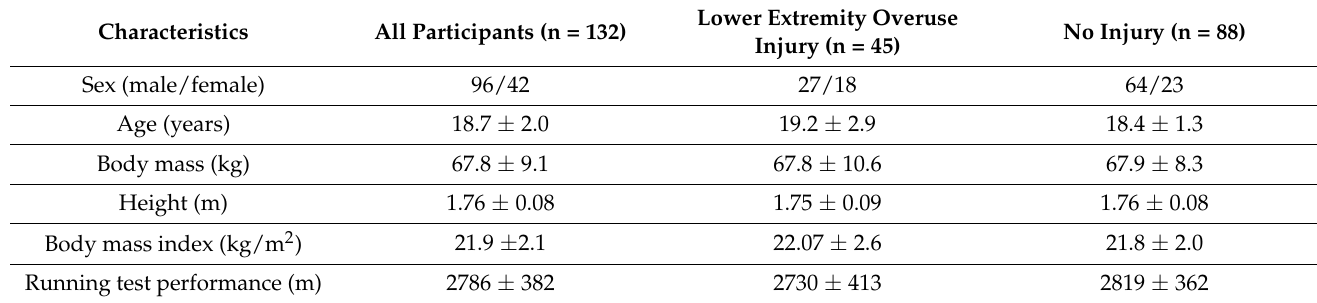
Table 1. Descriptive characteristics for all participants. Values are means ± SD.